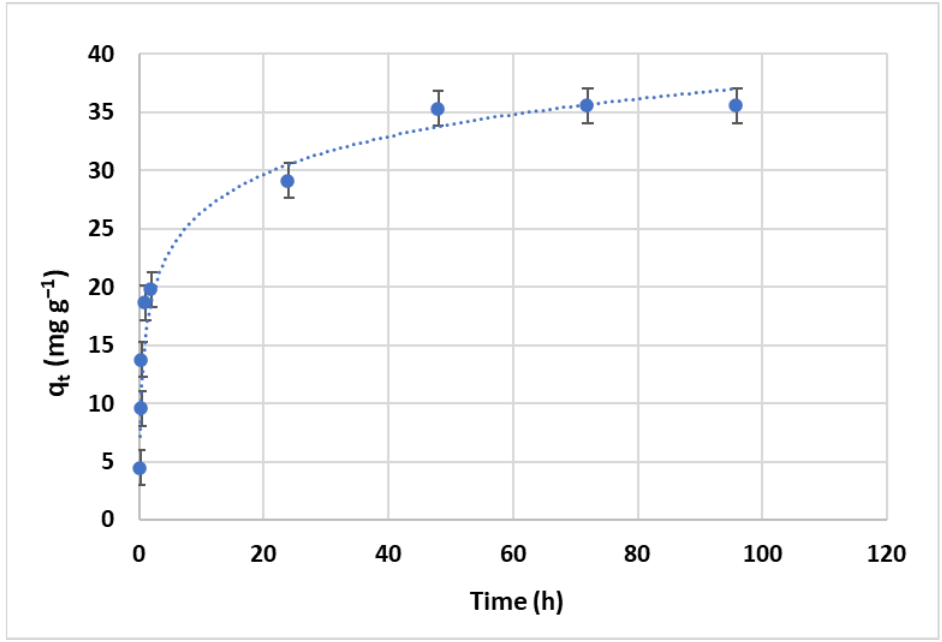
Figure 10. Effect of time on the adsorption capacity (m = 0.01 g, C 0 = 90 mg L −1 , V = 10 mL, pH = 4 and T = 298 K).